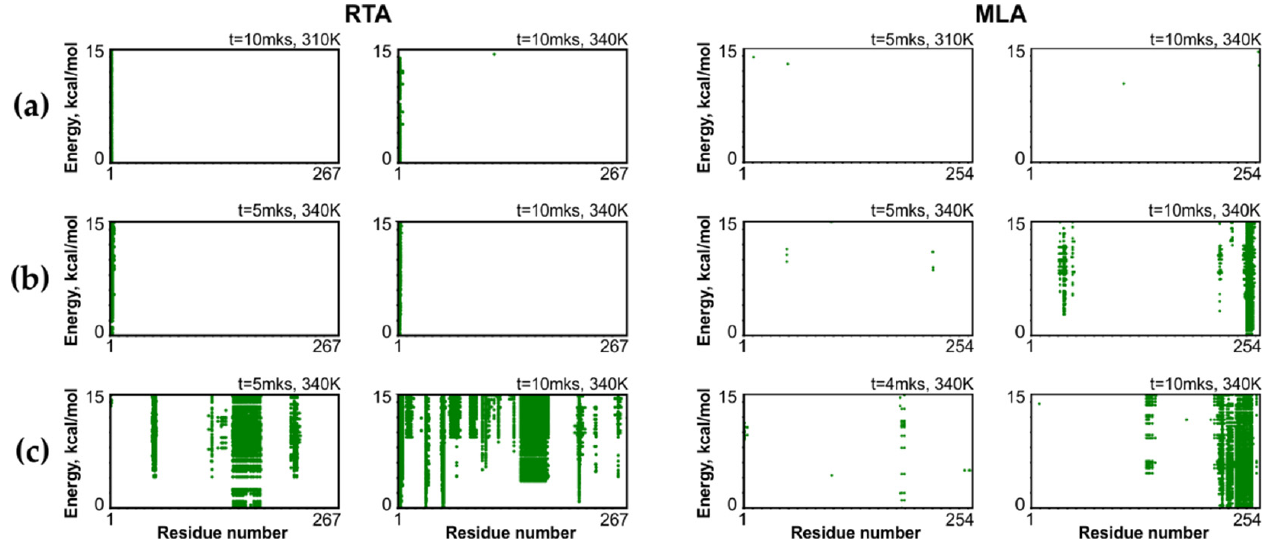
Figure 7. MC simulations of different solvent-adapted models of RTA (left two columns) and MLA in the presence of the membrane-mimicking hydrophobic slab. The maps of the contacts of the toxin residues with the membrane in the lowest-energy MC-states ( Y -axis: total energy of the system) are shown with green dots. Contact maps for protein– membrane interactions are given as horizontal rows of panels corresponding to protein structures adapted to different solvents (results of the MD simulations): water ( a ), urea/water ( b ), and chloroform/methanol ( c ). The MD conditions under which each of the models was obtained are indicated in each panel. In all cases, the value of the lowest- energy MC-state (Emin.) was assigned to zero.